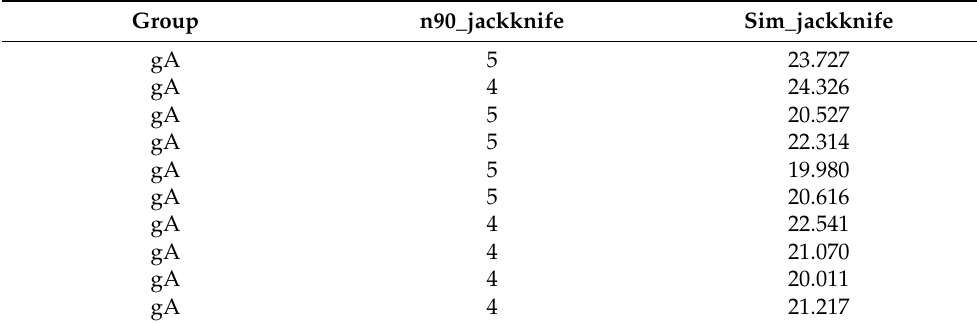
Table A2. Jack-knife results table obtained using the N90_resampling function for group A (gA) from the $N90_jackknifes object. n90_jackknife and Sim_jackknife are the values of the n 90 and the total similarity values in each re-sampling step, respectively.